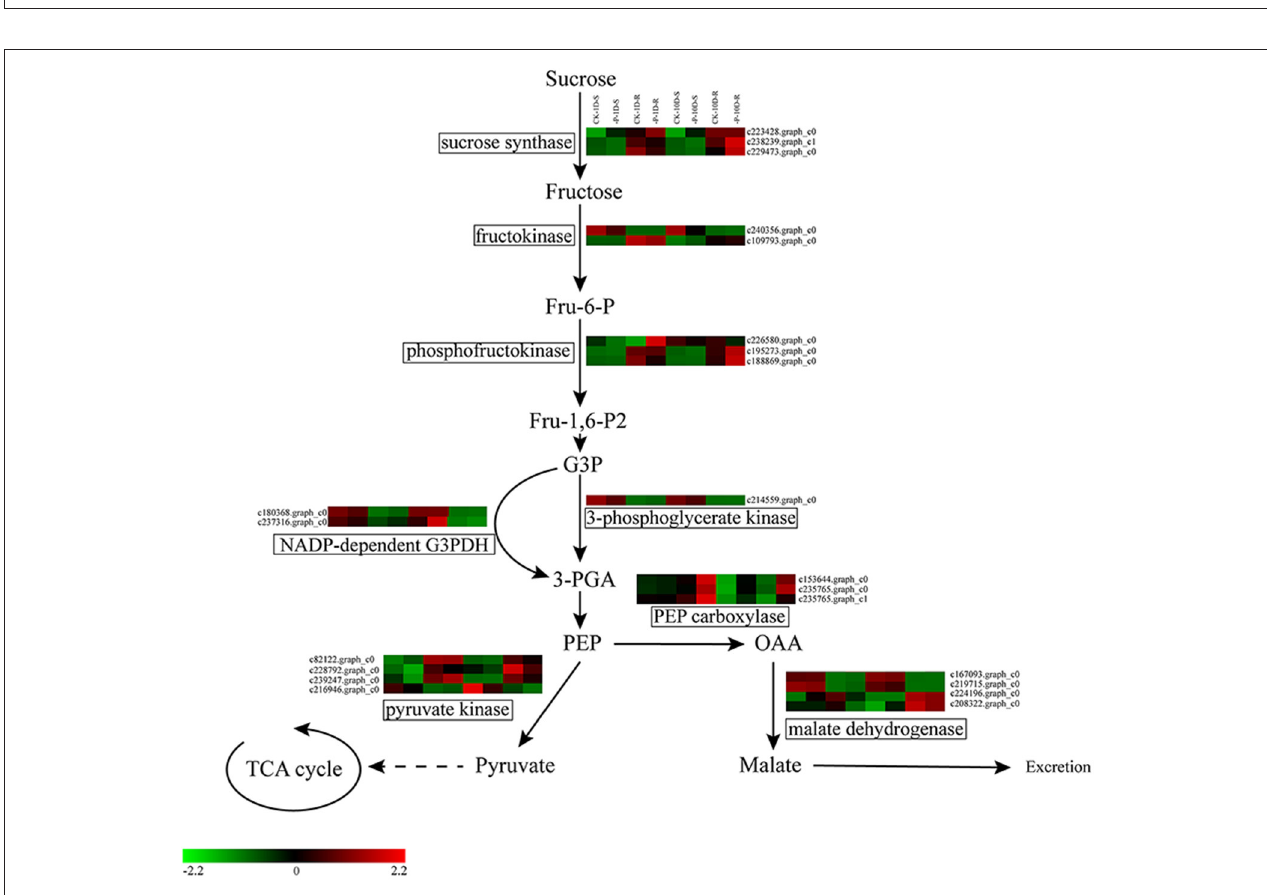
FIGURE 5 | Heatmap of the DEGs involved in glycolysis and organic acid synthesis pathways. Expression, represented by Z scores, is shown for selected DEGs due to -P conditions. Red indicates high expression, black indicates intermediate expression, and green indicates low